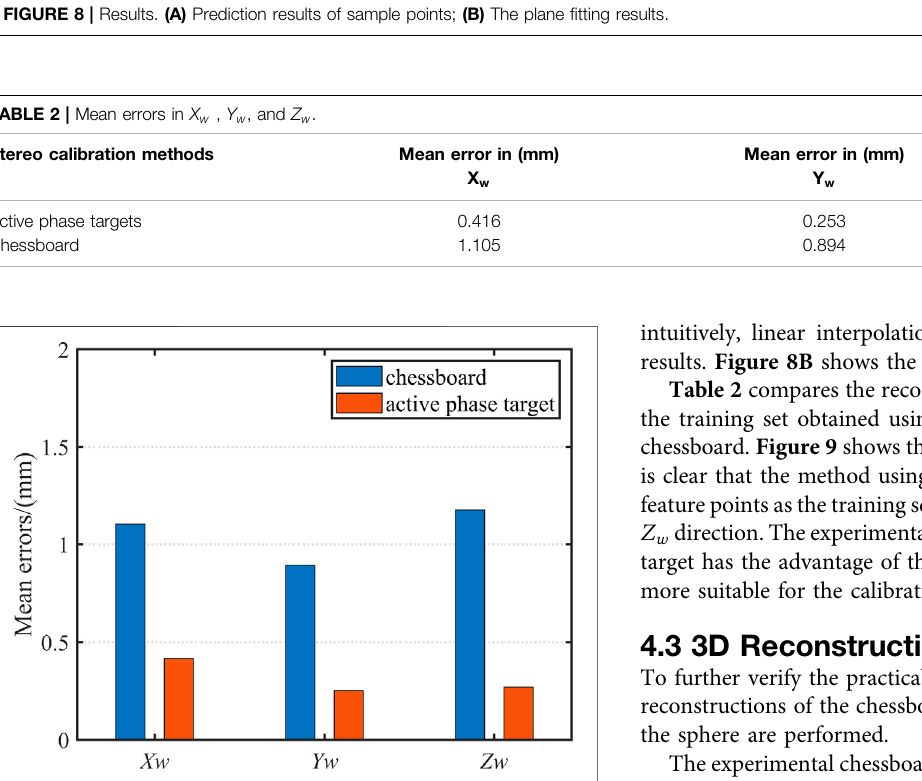
FIGURE 8 | Results. (A) Prediction results of sample points; (B) The plane fi tting results.